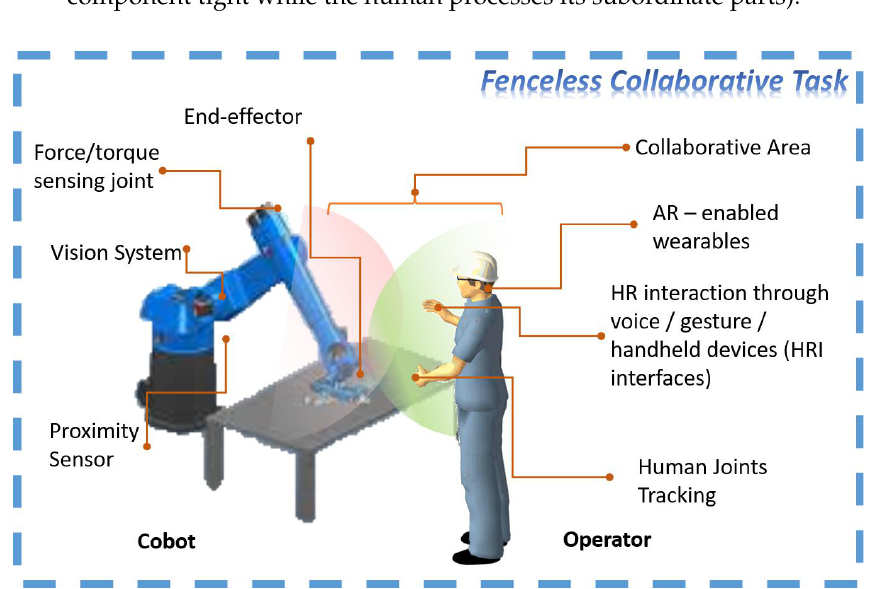
Figure 3. A graphical illustration of a fenceless collaborative topology including an operator and a collaborative robot along with the safety